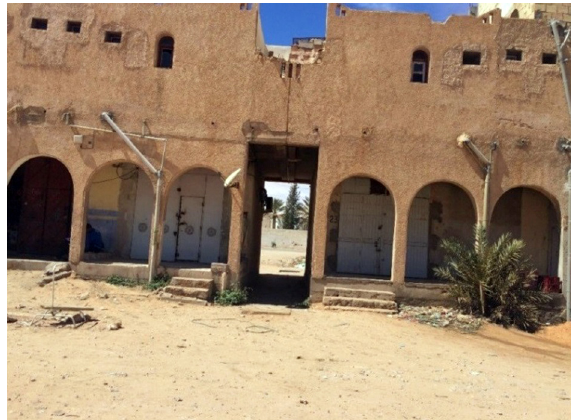
Fig. 7. View of the passage and gallery with semi- circular arcades. Source: Rahmani, May 2018.